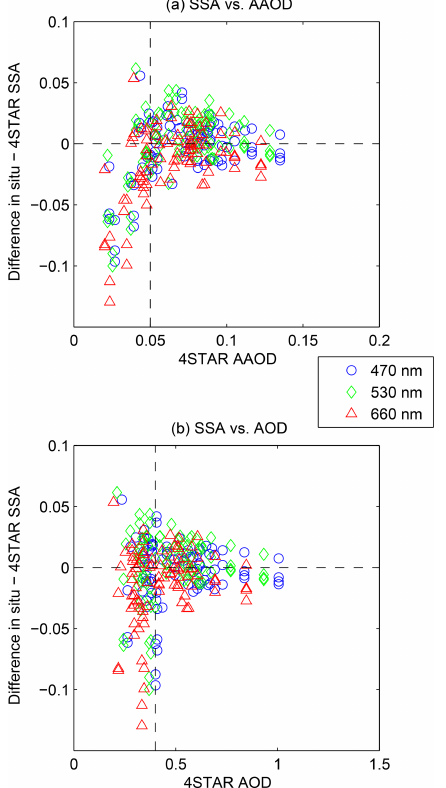
Figure 11. (a) SSA from all measurements/retrievals over ORACLES-2016, from 4STAR, AirMSPI, and the nephelometer and PSAP in situ data. The campaign-wide median is indicated by the thick solid line, 25th–75th percentiles are indicated by thin solid lines, and 10th–90th percentiles are indicated by the dashed lines. Note that the medians of the different instruments are not strictly comparable, as the campaign-wide averages are calculated using more data than just the coincident cases. The inset shows the spatial distribution (latitude/longitude) of measurements by the three instruments. (b) The median SSA by instrument as shown in panel (a) compared with SSA from previous studies in this same region (Fig.